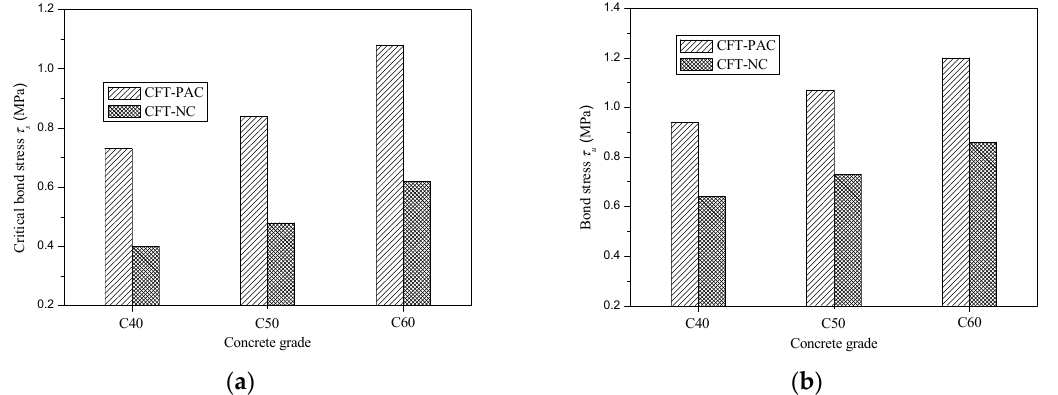
Figure 8. Variation of critical bond stress ( τ s ) and bond stress ( τ u ) with concrete strength and concrete type. ( a ) Critical bond stress ( τ s ); ( b ) Bond stress ( τ u ).